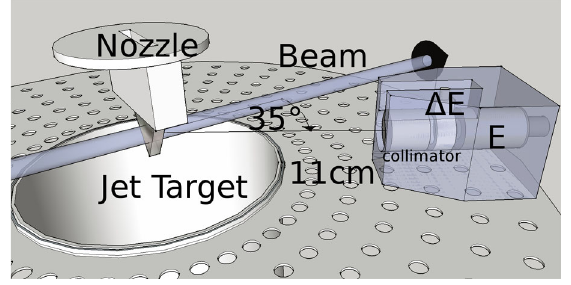
FIG. 9. Experimental setup. Inside the scattering chamber, a collimated E- Δ E telescope array was placed at 35° with respect to the beam axis, in order to measure forward reactions and elastic